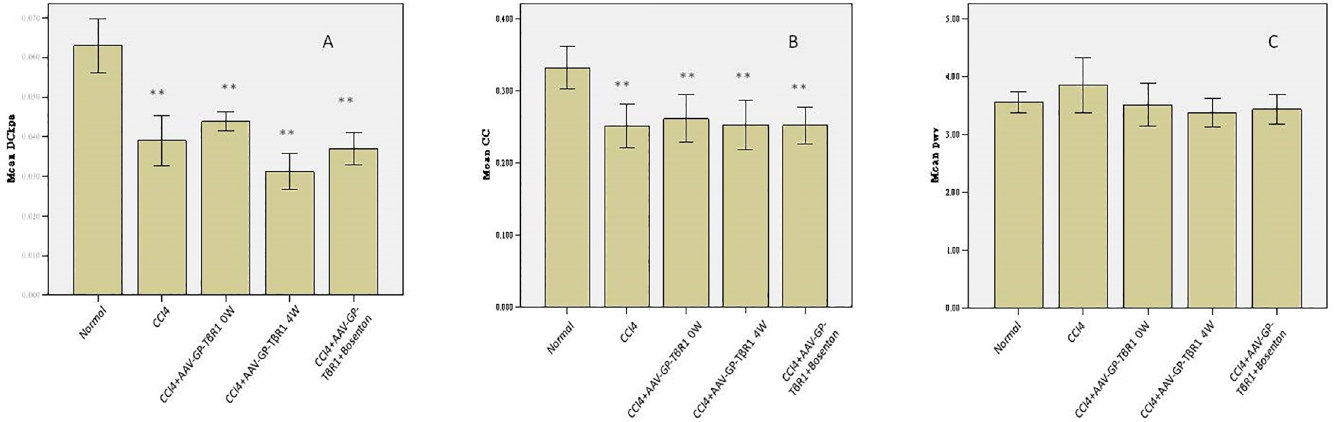
Fig 9. Comparison of abdominal aortic elasticity parameter values: (A)/(B) differences existed between the experimental groups and the control group, but differences among the various experimental groups were not statistically significant. (C) There were no significant differences in PWV between the experimental groups and the control